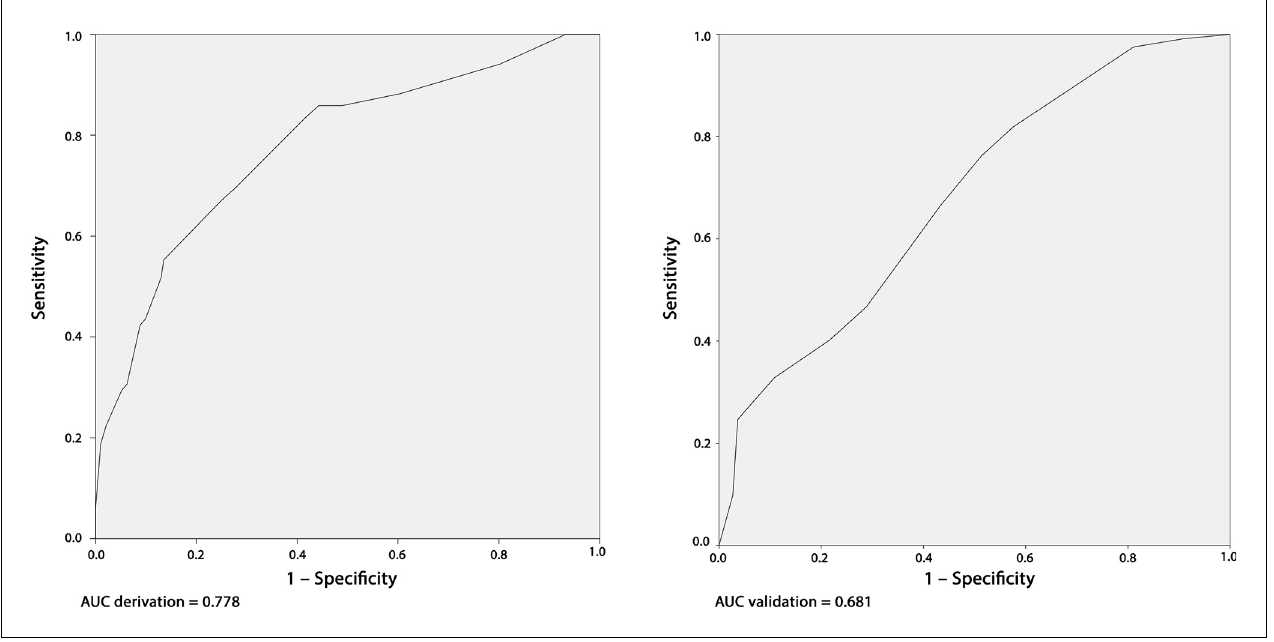
Figure 2. Receiver operating characteristic curves for the derivation and validation samples. AUC = area under curve.